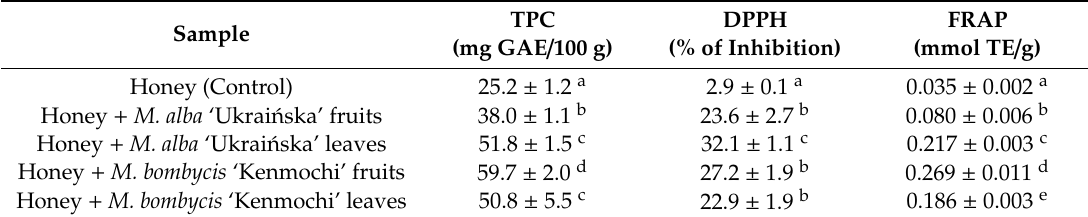
Table 4. Total phenolic compounds content (TPC), radical scavenging activity (DPPH test), and